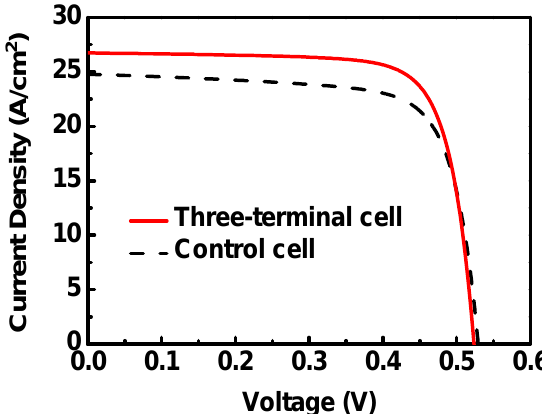
Figure 2. The J-V curve of the typical two-terminal (control) and the three-terminal μ c-Si solar cells. The efficiency of the three-terminal cell is 10.8%, and the efficiency of the control cell is